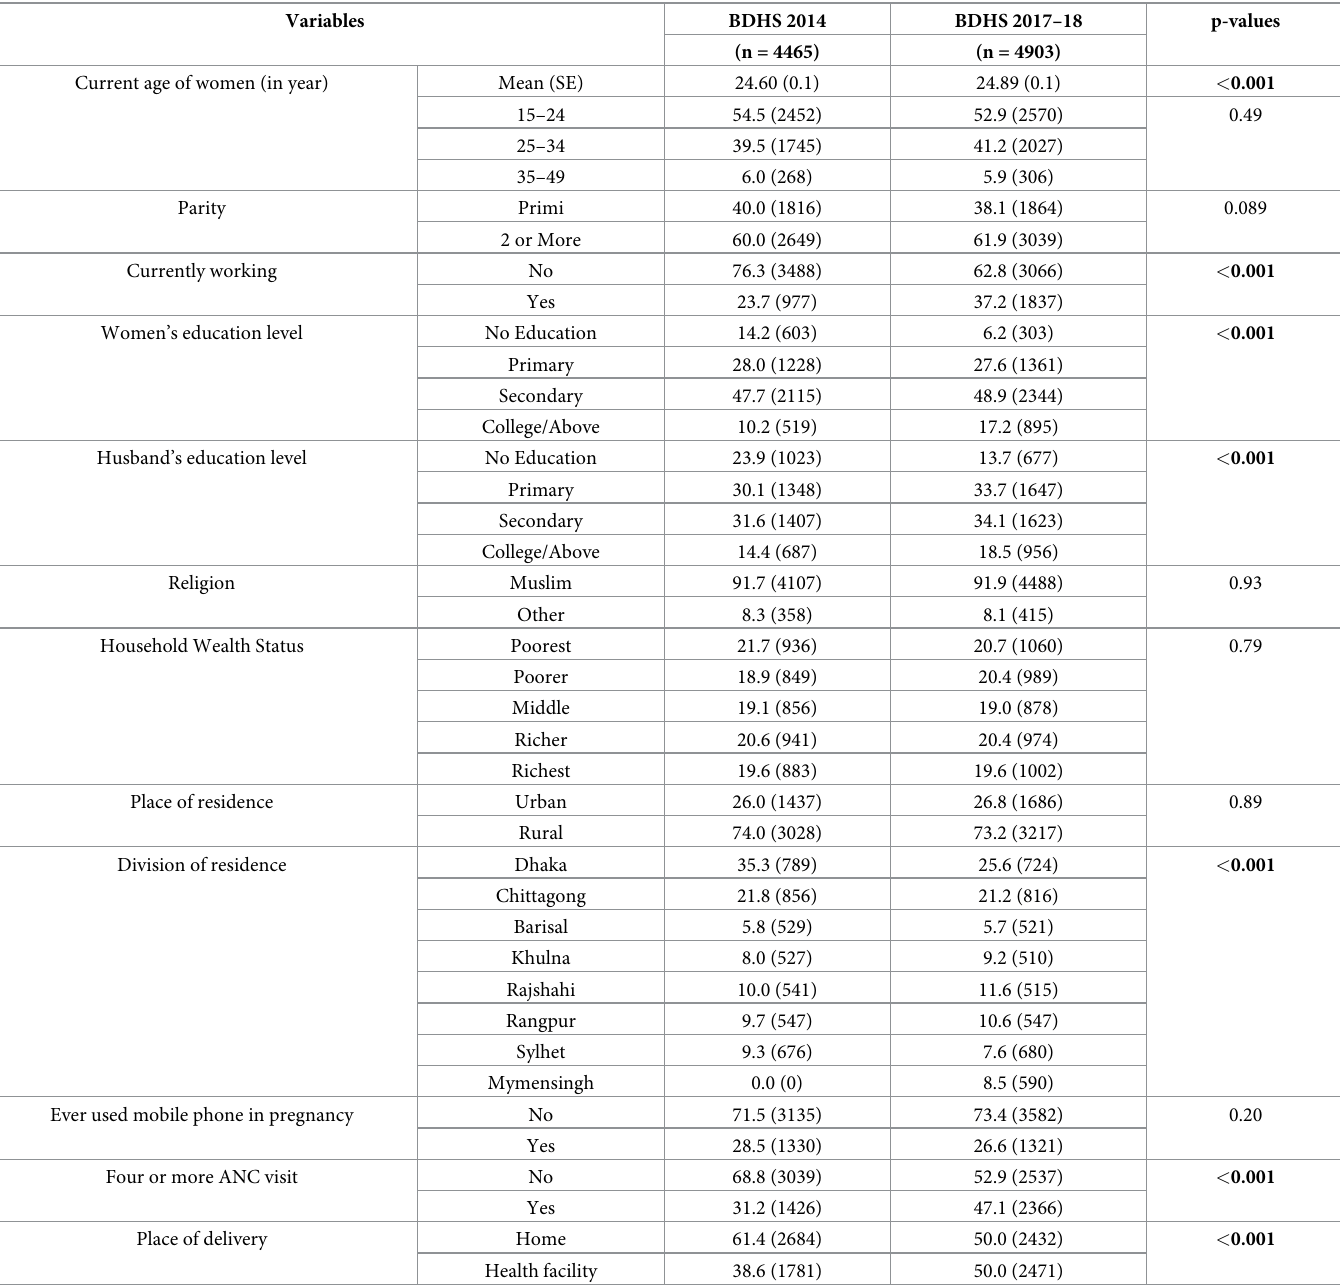
Table 1. Sociodemographic characteristics of the study participants by survey period, % (n) (N = 8876) BDHS 2014 and BDHS